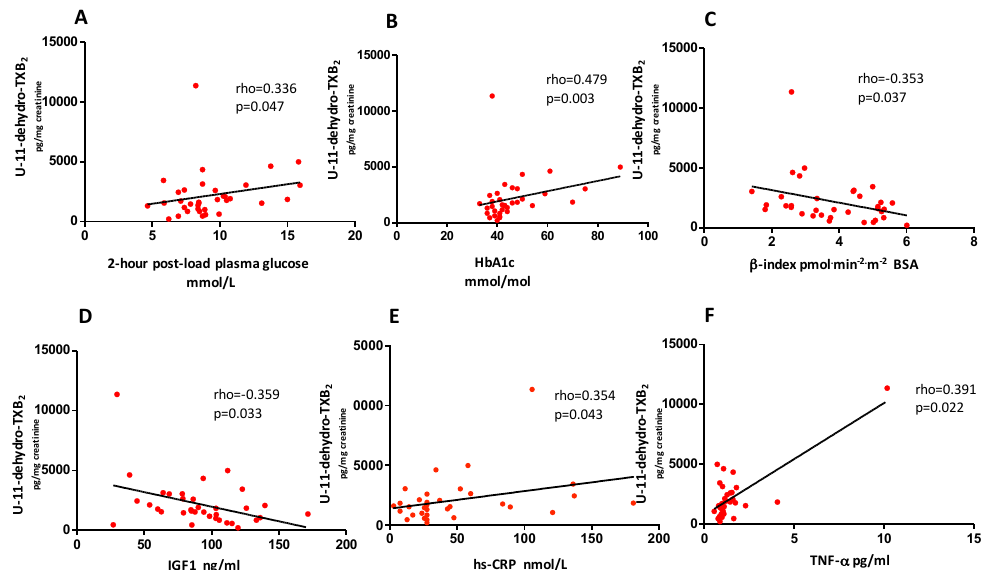
Figure 2. Baseline correlations between platelet activation and metabolic control, beta cell function, IGF-I, and systemic inflammation in obese patients with prediabetes or early type 2 diabetes. Basal correlations between U-11-dehydro-TXB 2 and 2-h post-load plasma glucose (panel A ), HbA1c (panel B ), beta cell function as assessed by beta index (panel C ), IGF-I (panel D ), systemic inflammation as assessed by hs-CRP (panel E ) and TNF- α (panel F ) in obese patients with prediabetes or newly diagnosed type 2 diabetes. IGF-I, insulin growth factor-I, hs-CRP, high sensitivity C-reactive protein, TNF, tumor necrosis factor.